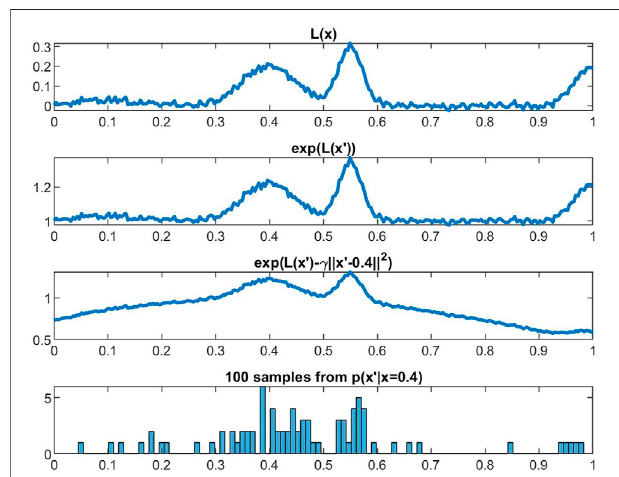
FIGURE 2 | Illustration of the sampling procedure in Assumption 2 at fi xed weights w . The distribution produces samples x ′ from distribution p ( x ′ | x (cid:1) 0.4),andwecomputetheaveragelossoverthesesamples.Effectively,this encourages ATENT to search for w where L ( x ; w ) is relatively fl at in the neighborhood of x